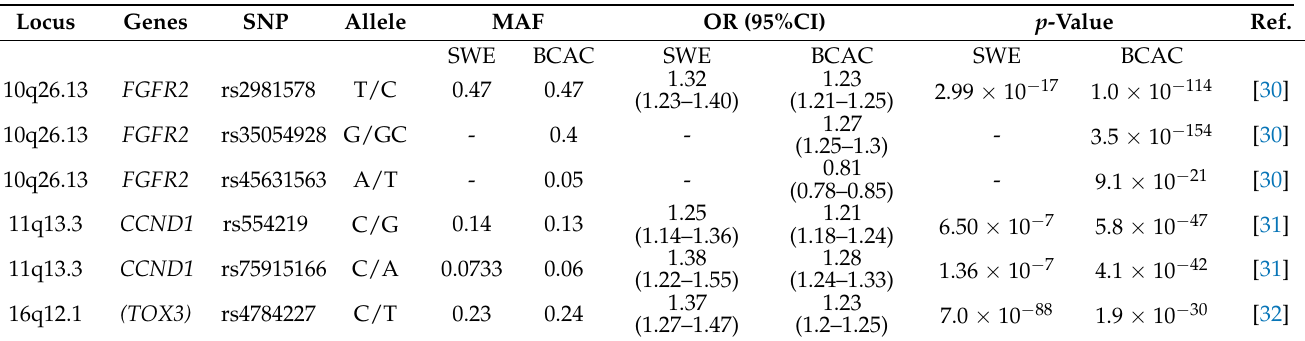
Table 2. Published SNPs within the three loci on Chromosome 10, 11 and 16 in comparison with our